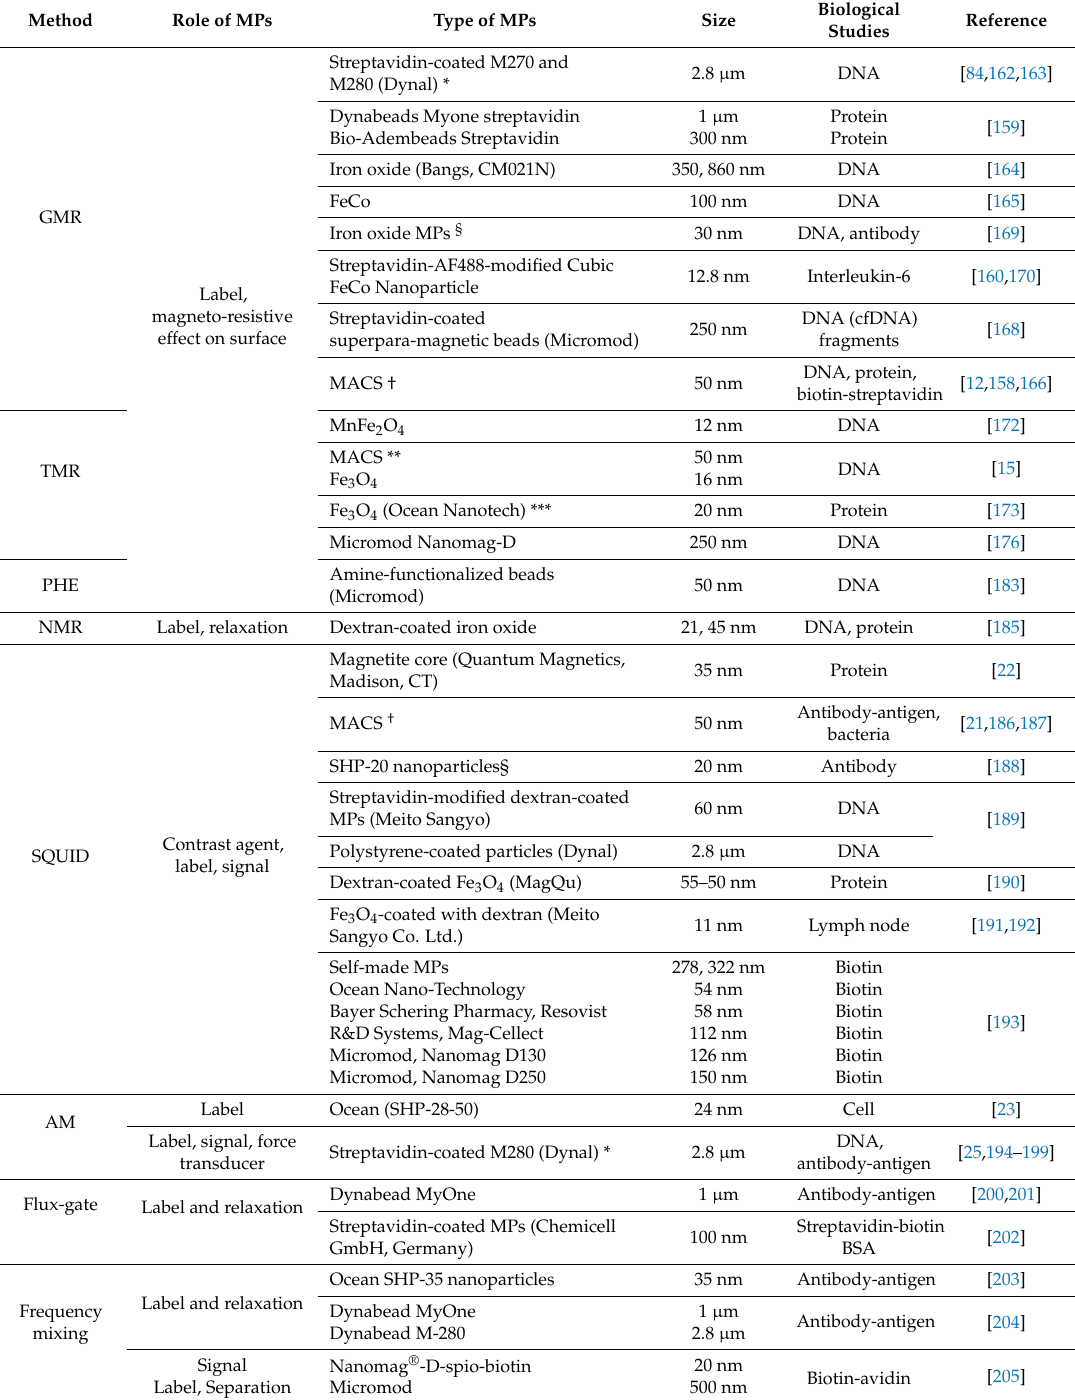
Table 3. MPs Detected by Various Magnetometer-Based Biosensing